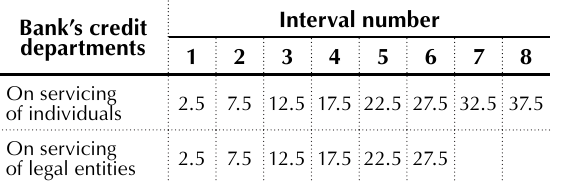
Table 7. Average customer service time interval